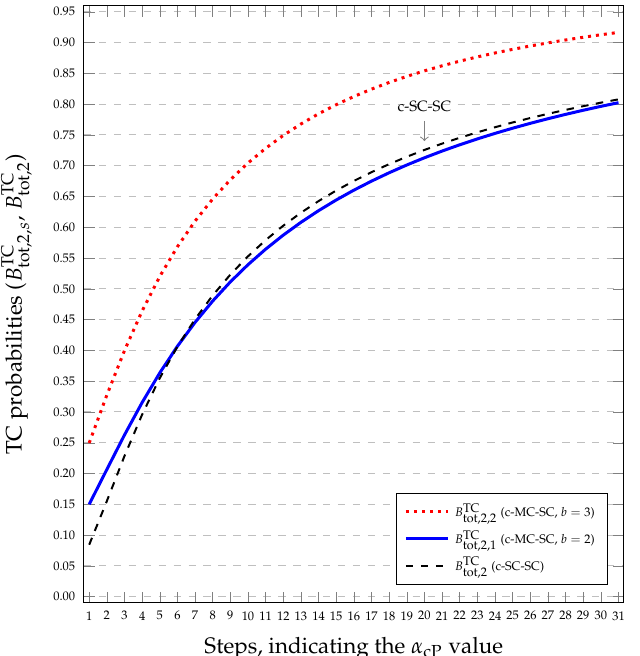
( s = 1,2), for of all service-classes in the 2nd RRH (c-MC-SC tot,2, s